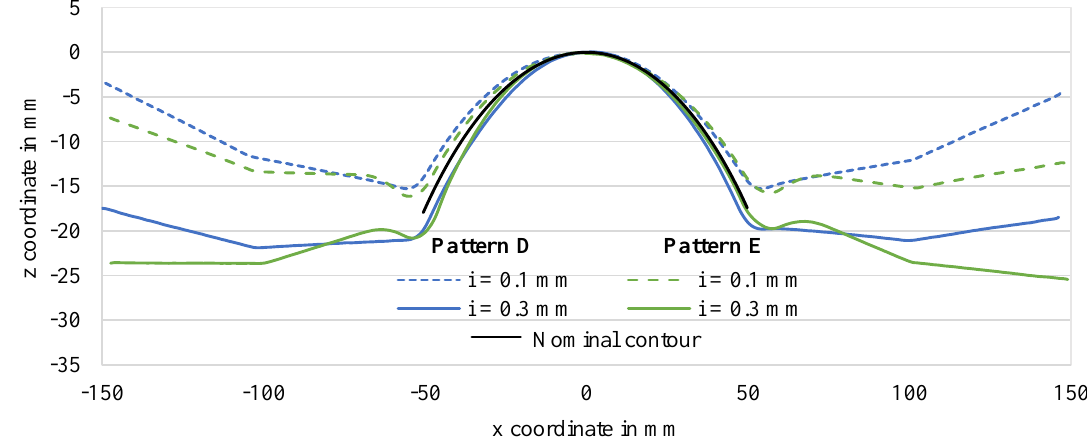
ff erent path patterns and intrusion